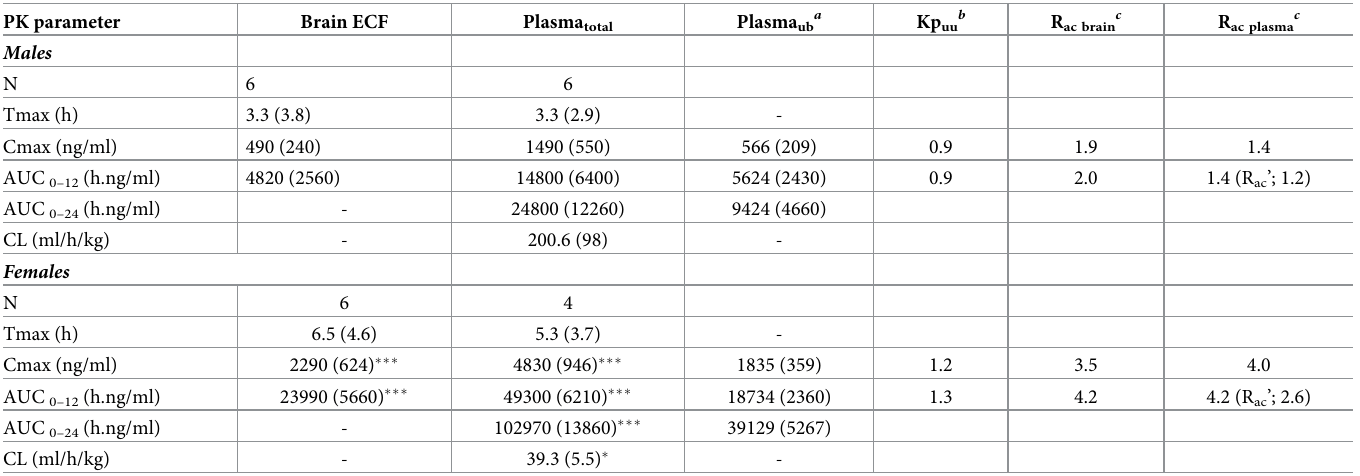
Table 3. Steady state brain and plasma pharmacokinetics, accumulation indices and unbound partition coefficients (Kp uu) of letrozole in both male and female Sprague-Dawley